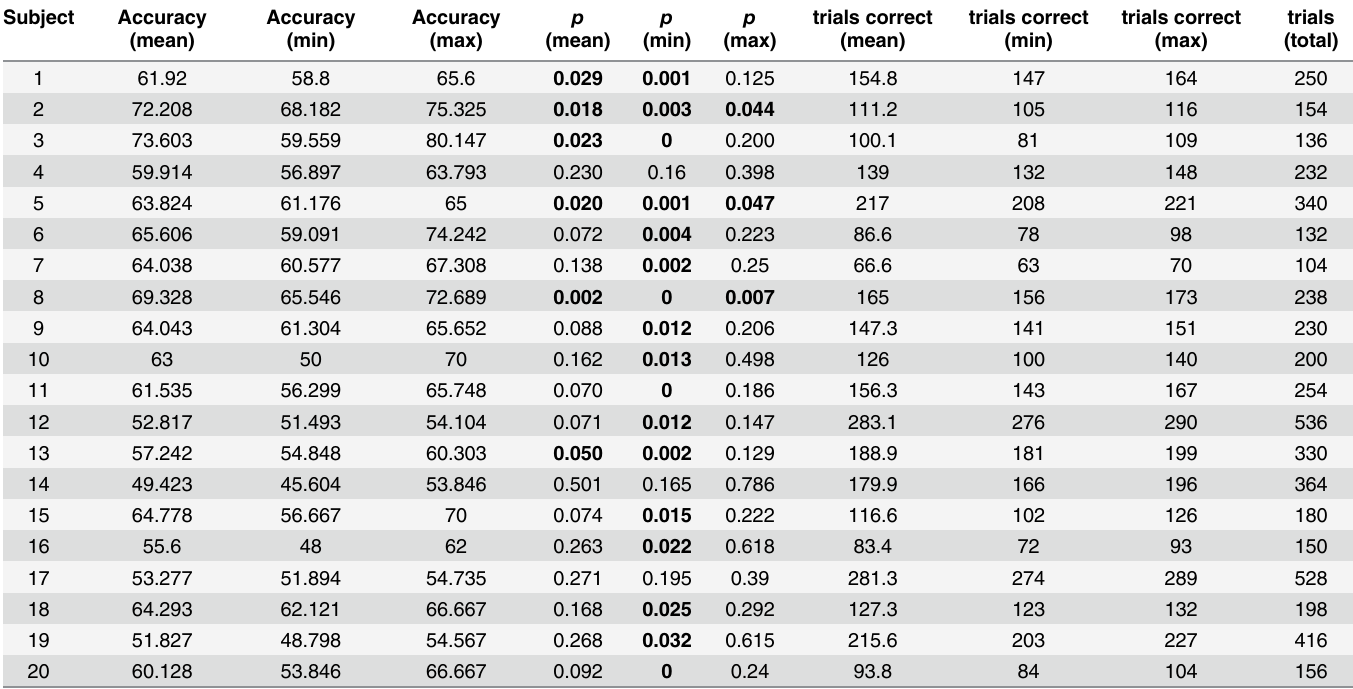
Table 8. Results Across Task Ne: Train Flanker, Classify